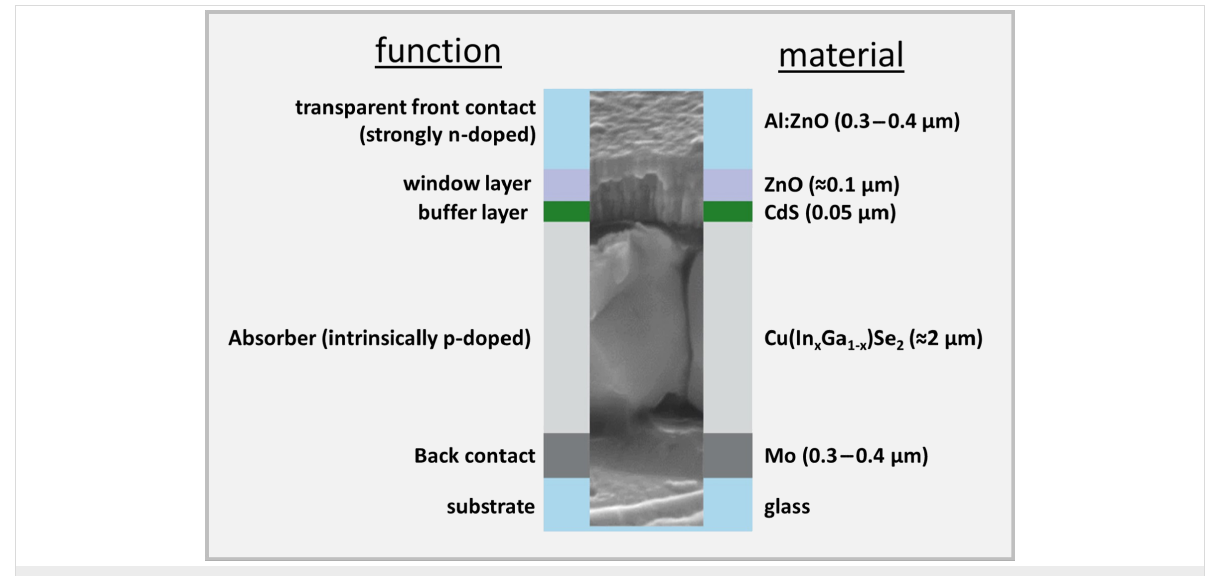
Figure 1: Design of a planar CIGSe solar cell.